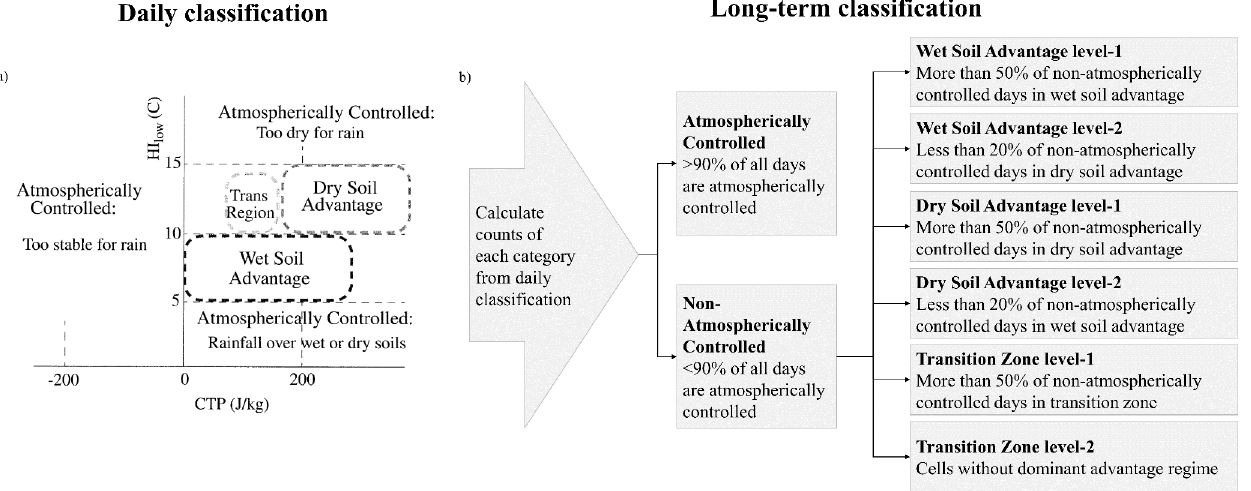
Figure 1. Schematic depicting the coupling strength classification with the convective triggering potential – low-level humidity (CTP- HI low ) framework by Findell and Eltahir (2003a, b) (adopted from Jach et al., 2020). Panel (a) shows the threshold values from Findell and Eltahir (2003a); their Fig. 15. Panel (b) summarizes the approach for the long-term classification as explained in Findell and Eltahir